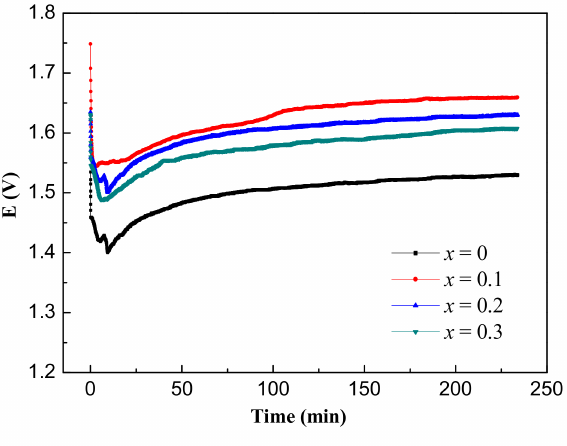
Figure 6. The discharge curves of the AAB based on the Al-1Zn-0.1In-0.1Sn-0.5Mg-xMn (x = 0, 0.1,